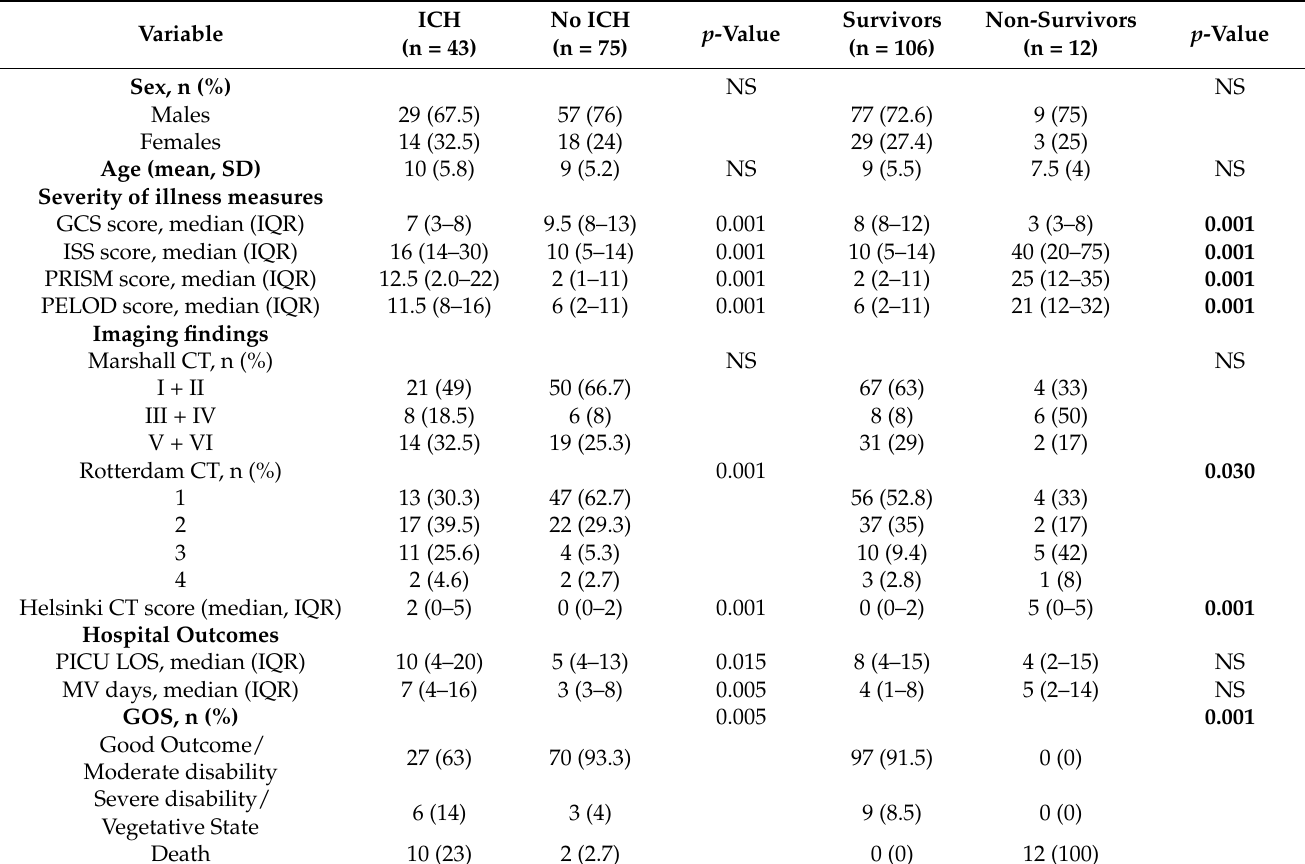
Table 2. Descriptive statistics by outcome